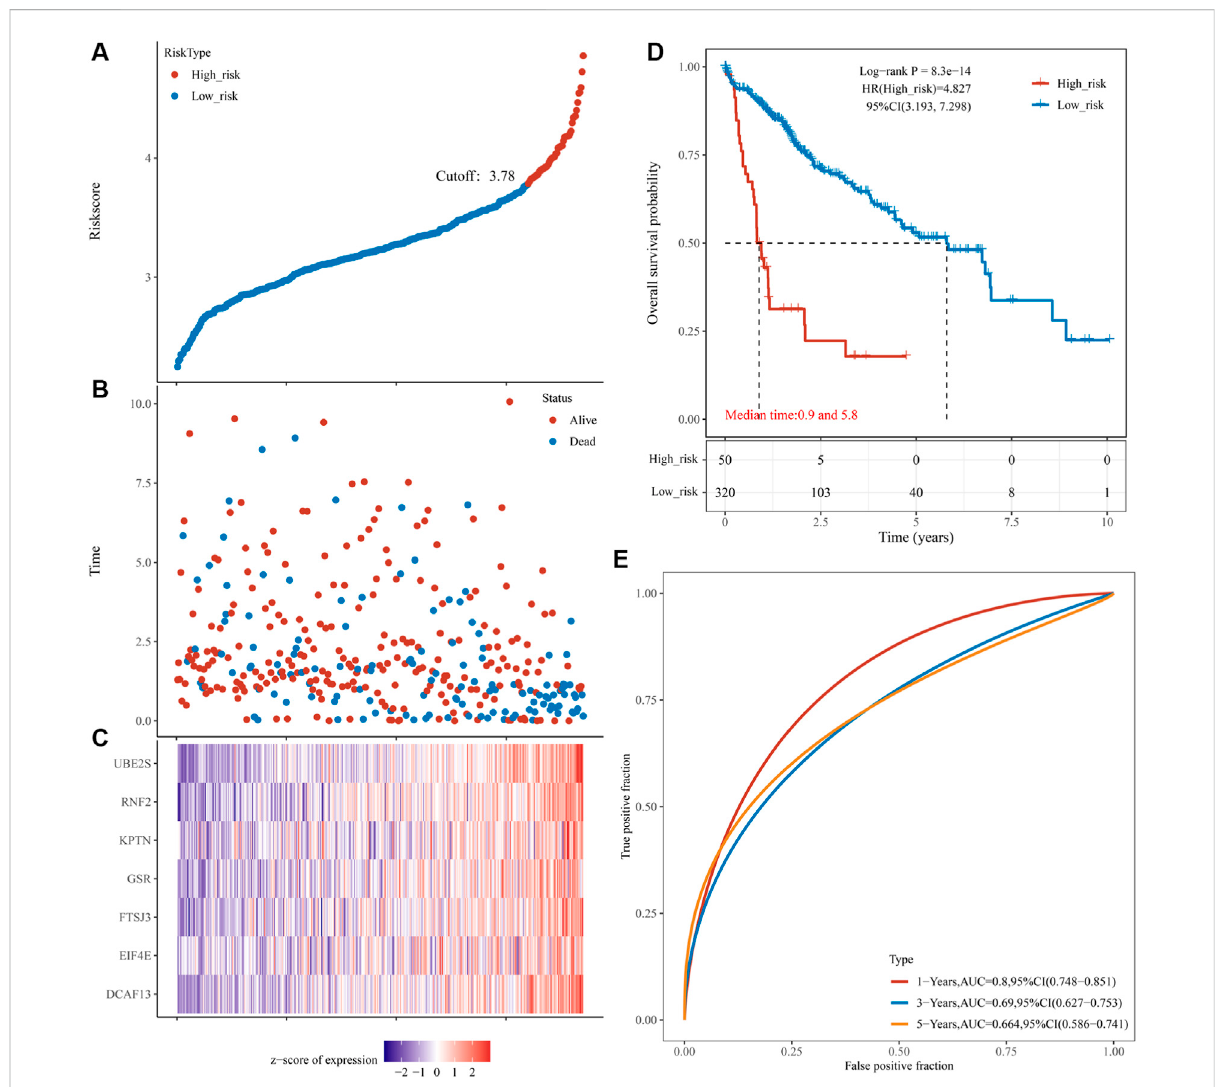
FIGURE 7 Prognostic risk score features of pyroptosis-regulated genes in the training group and validation group 1. (A) The scatterplot showing the riskscore from low to highinthetraining set.The bluecolor indicates lowrisk group. The yellow colorindicates highrisk group (thesame below). (B) The scatter plot reveals the distribution of the risk score of each sample corresponding to the survival time and survival status in the training set. (C) The heatmap showing the gene expression patterns of the pyroptosis-regulated signature. (D) Kaplan-Meier Plotter of the risk model of the training set. Difference groups were compared using the log-rank test. (E) The ROC curve at 1, 3 and 5 years and AUC of the pyroptosis-regulated